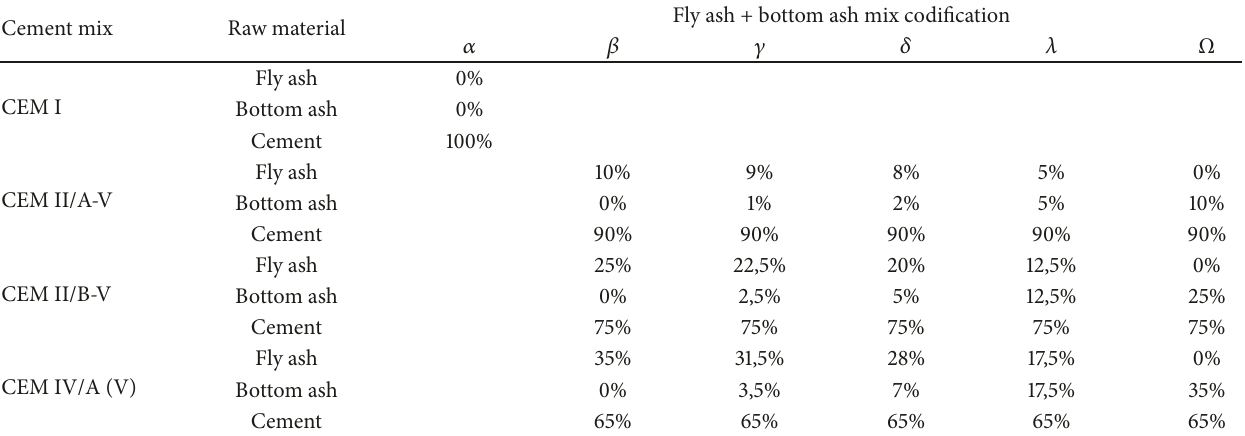
Table 2: Bottom ash (BA) with fly ash (FA) and cement (CEM I 42.5 N)